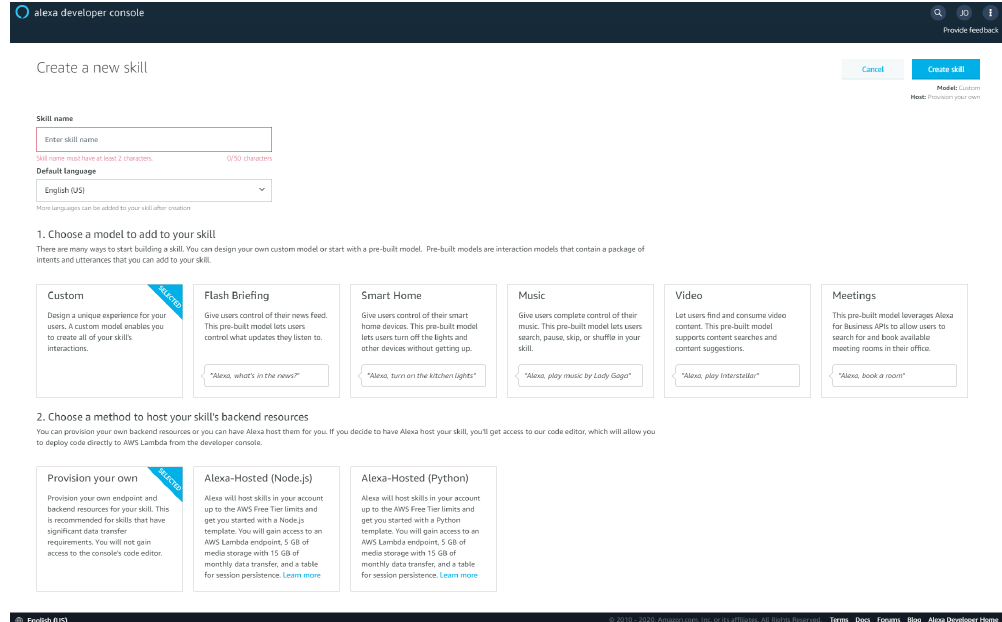
Figure 4. Alexa Developer Console: View for creating a new